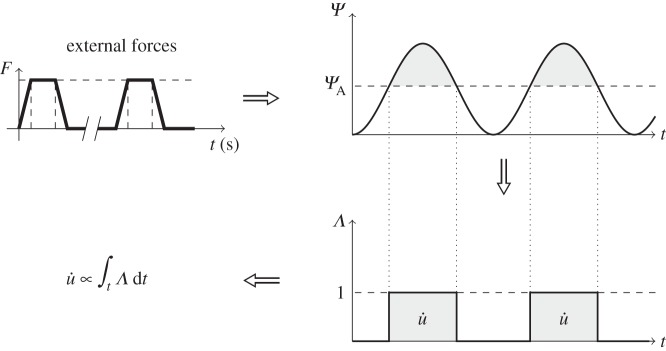
Cortical bone adaptation model. An externally applied force elicits a mechanical signal/stimulus, Ψ, in the bone. If this stimulus is above a certain apposition threshold, ΨA, then an adaptive response is generated (Λ = 1). This response is integrated over time to give the adaptation rate (u̇).